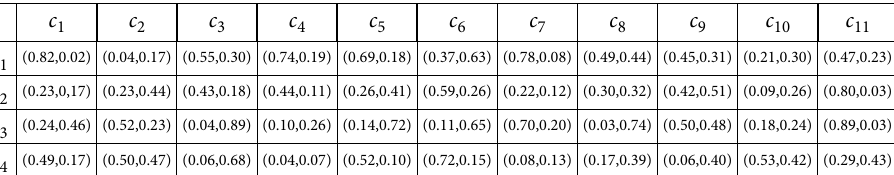
Table 3. Evaluation matrix